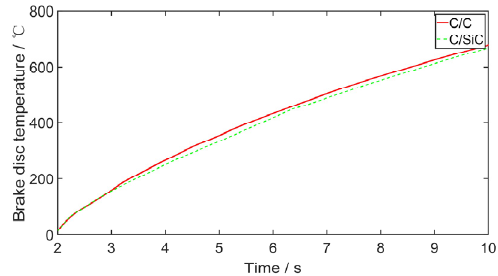
Figure 14. Comparison of brake disc temperature.